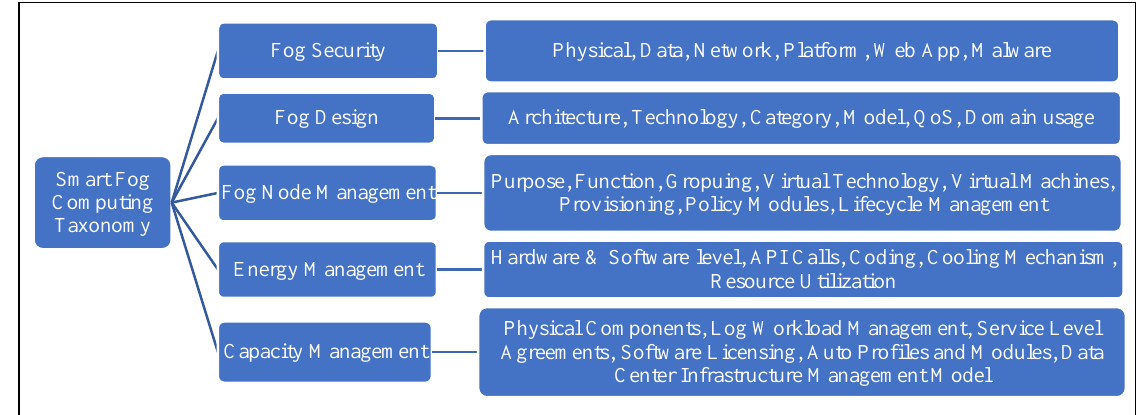
Figure 2. Proposed Taxonomy for Smart Fog Computing